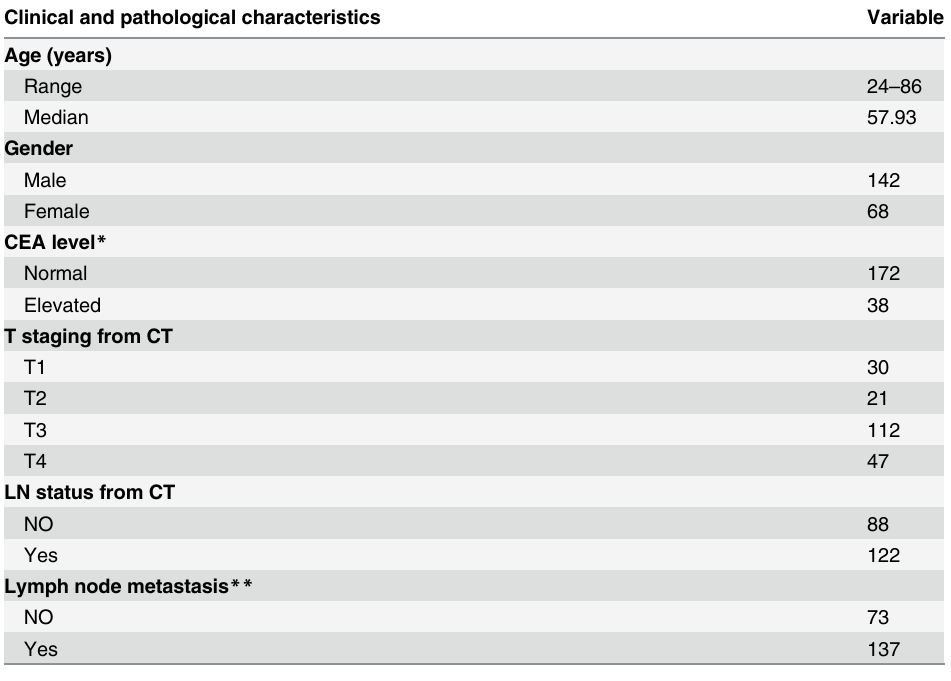
Table 2. The clinicopathologic features in validation